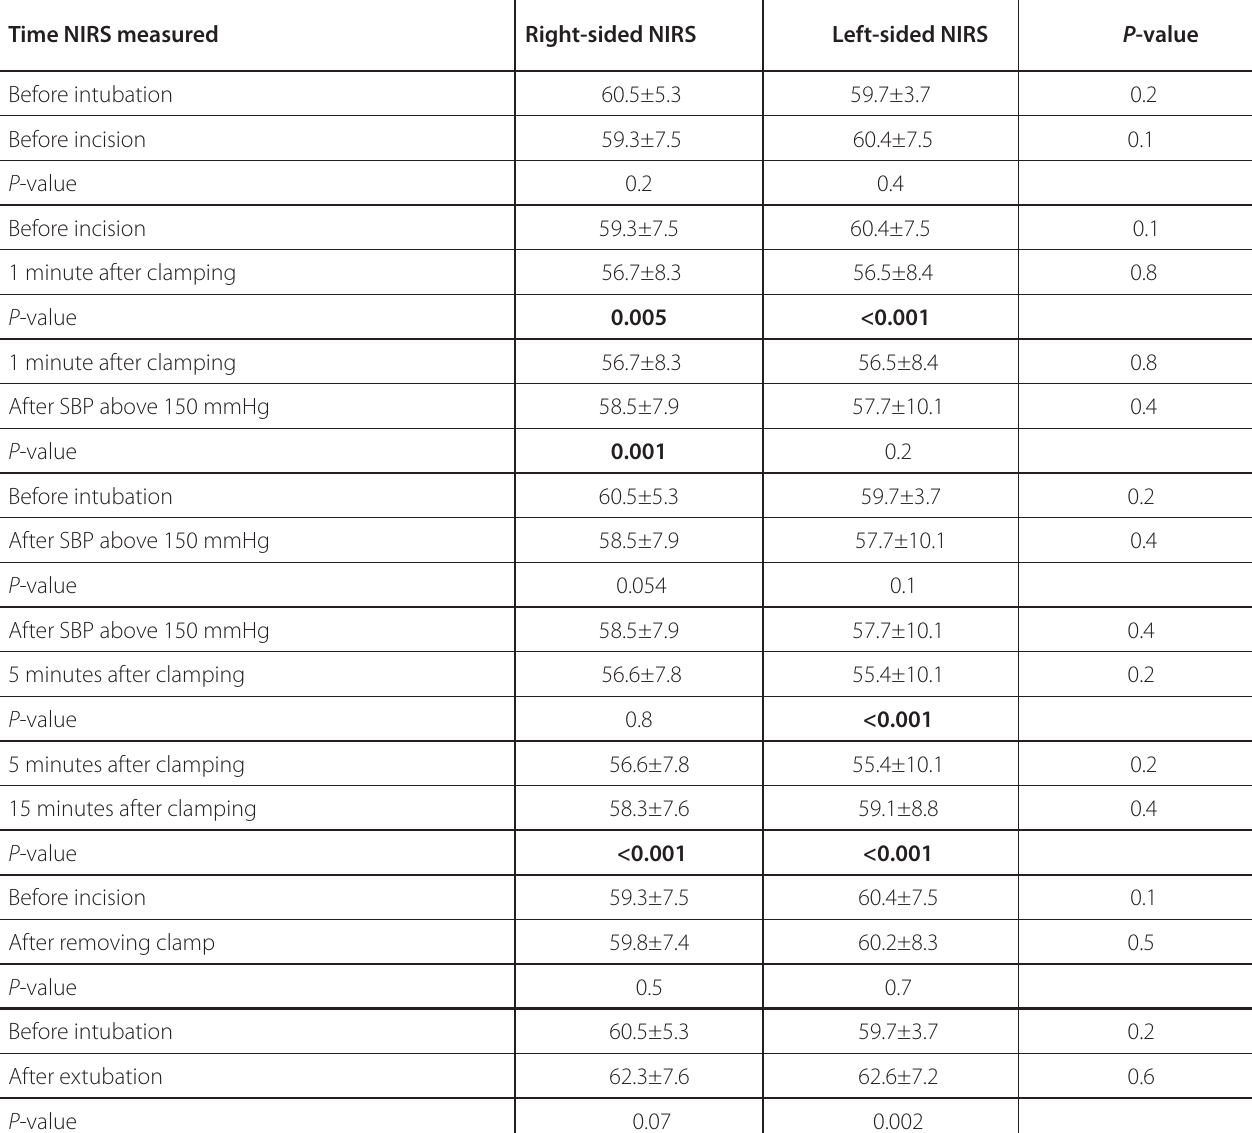
Table 3 . Comparison of NIRS values at different time